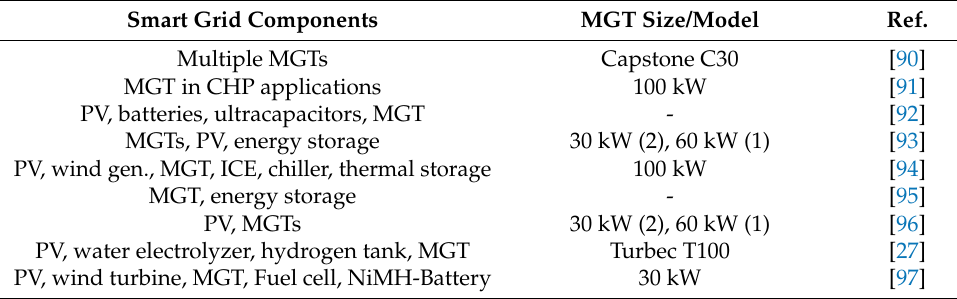
Table 7. Summary of MGT in DES and